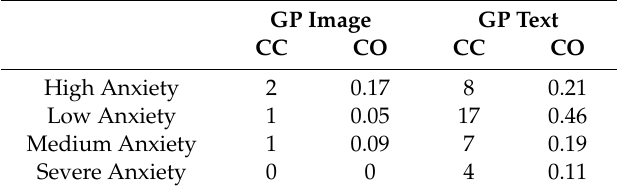
Table 22. Co-occurrence of gaze preference (GP) category and